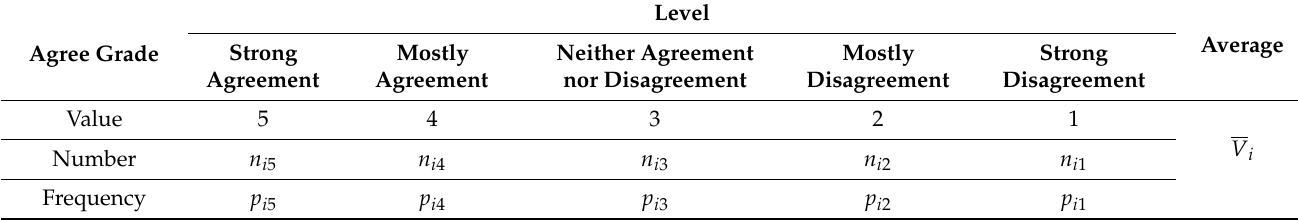
Table 5. Likert scale analysis